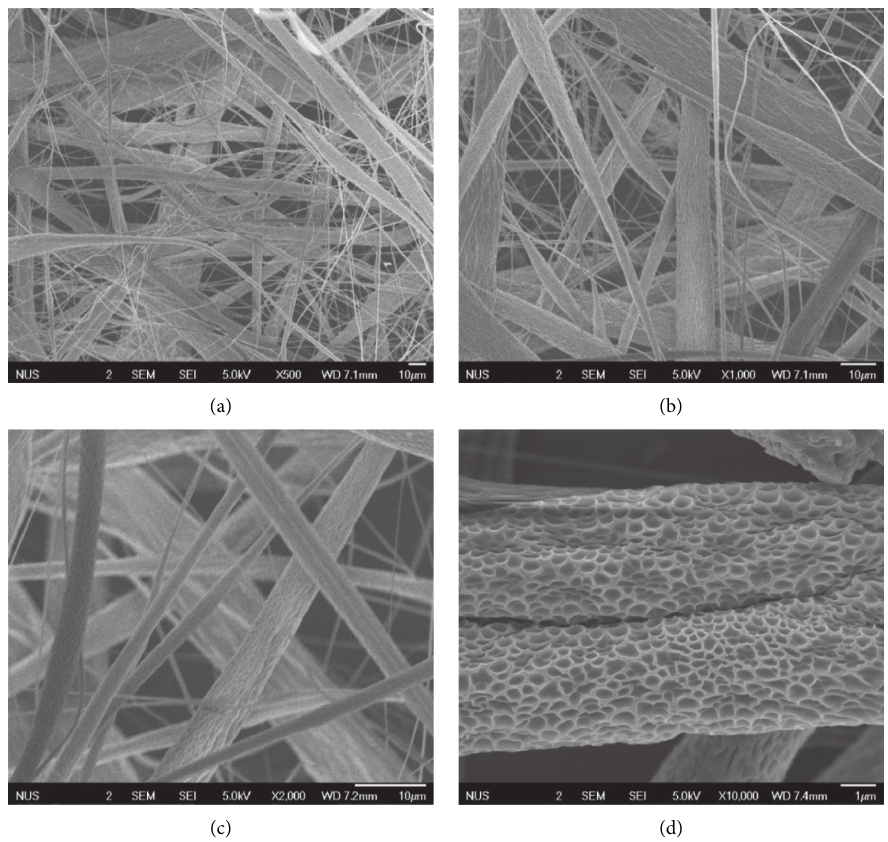
Figure 4: Scanning electron micrographs of PVC nanofibers at magnifications (a) × 500, (b) × 1,000, (c) × 2,000, and (d) ×